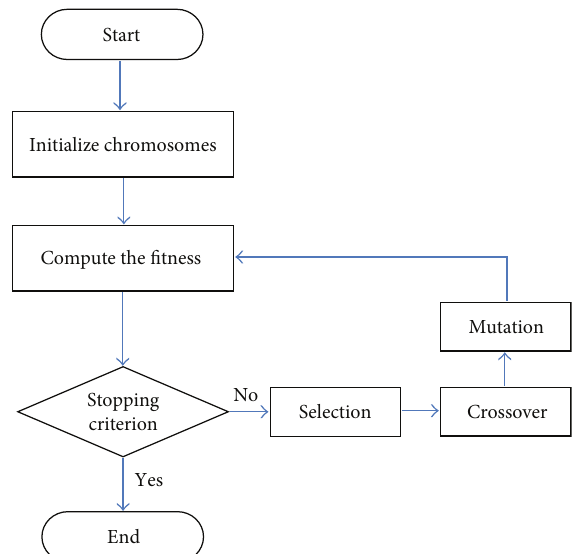
Figure 14: Genetic algorithm flow chart.